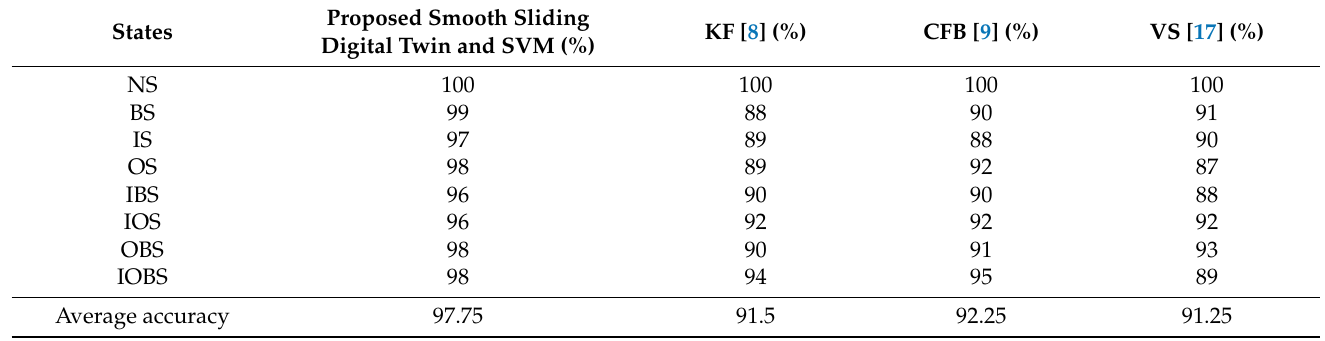
Table 6. Comparison between the proposed smooth sliding digital twin, Kalman filter (KF) [8], classical feedback backstepping (CFB) observer [9], and variable structure (VS) observer [17] for anomaly